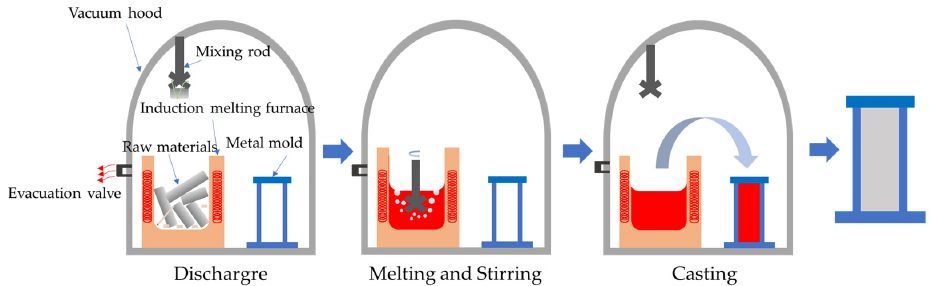
Figure 1. The schematic view of the purification process of Al-6Mg alloy.